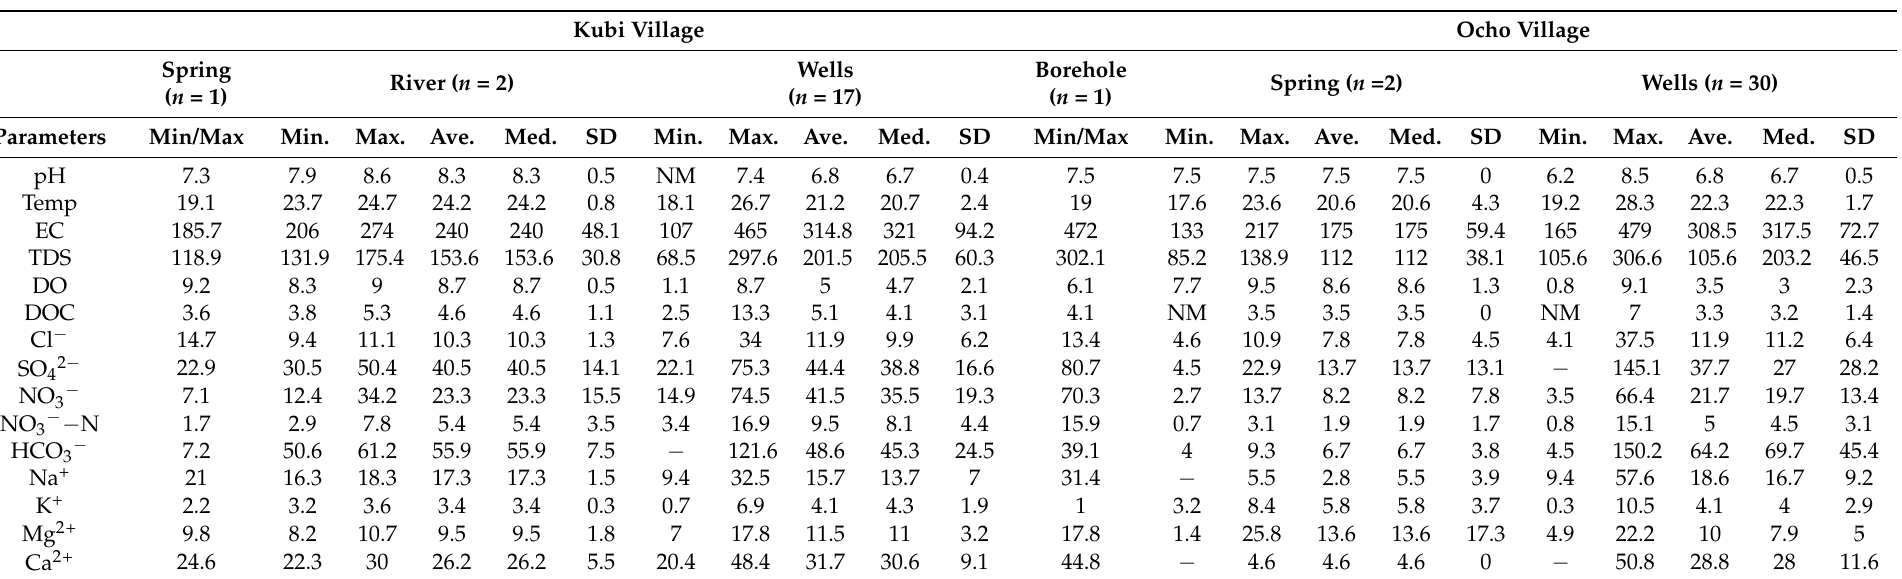
Table 1. Statistical characteristics of the hydrochemical compositions of the groundwater and surface water sources in Kubi and Ocho village. For values of individual samples, see Table S1 of Supplementary